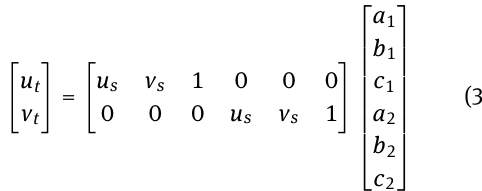
Figure 1: Residuals of